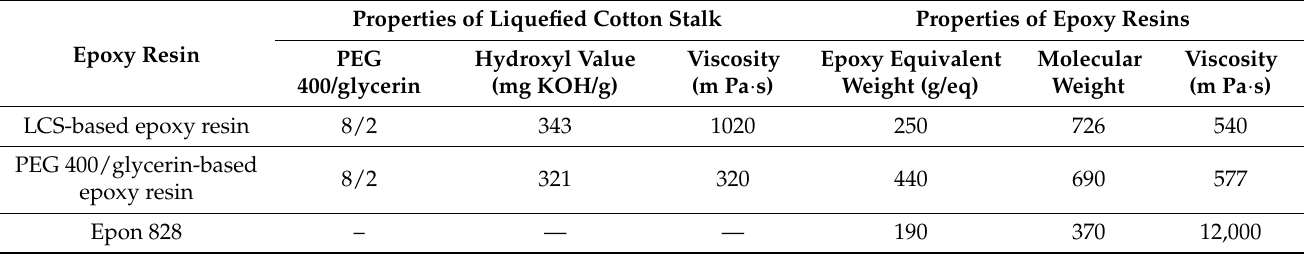
Table 2. Properties of liquefied cotton stalk-based epoxy